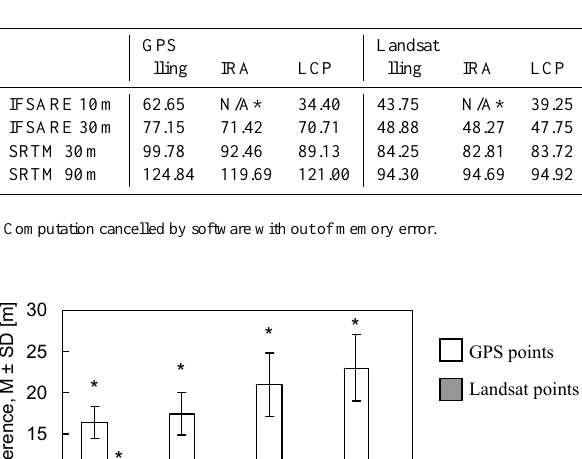
Table 2. Median distances of reference points to nearest extracted stream in meters.